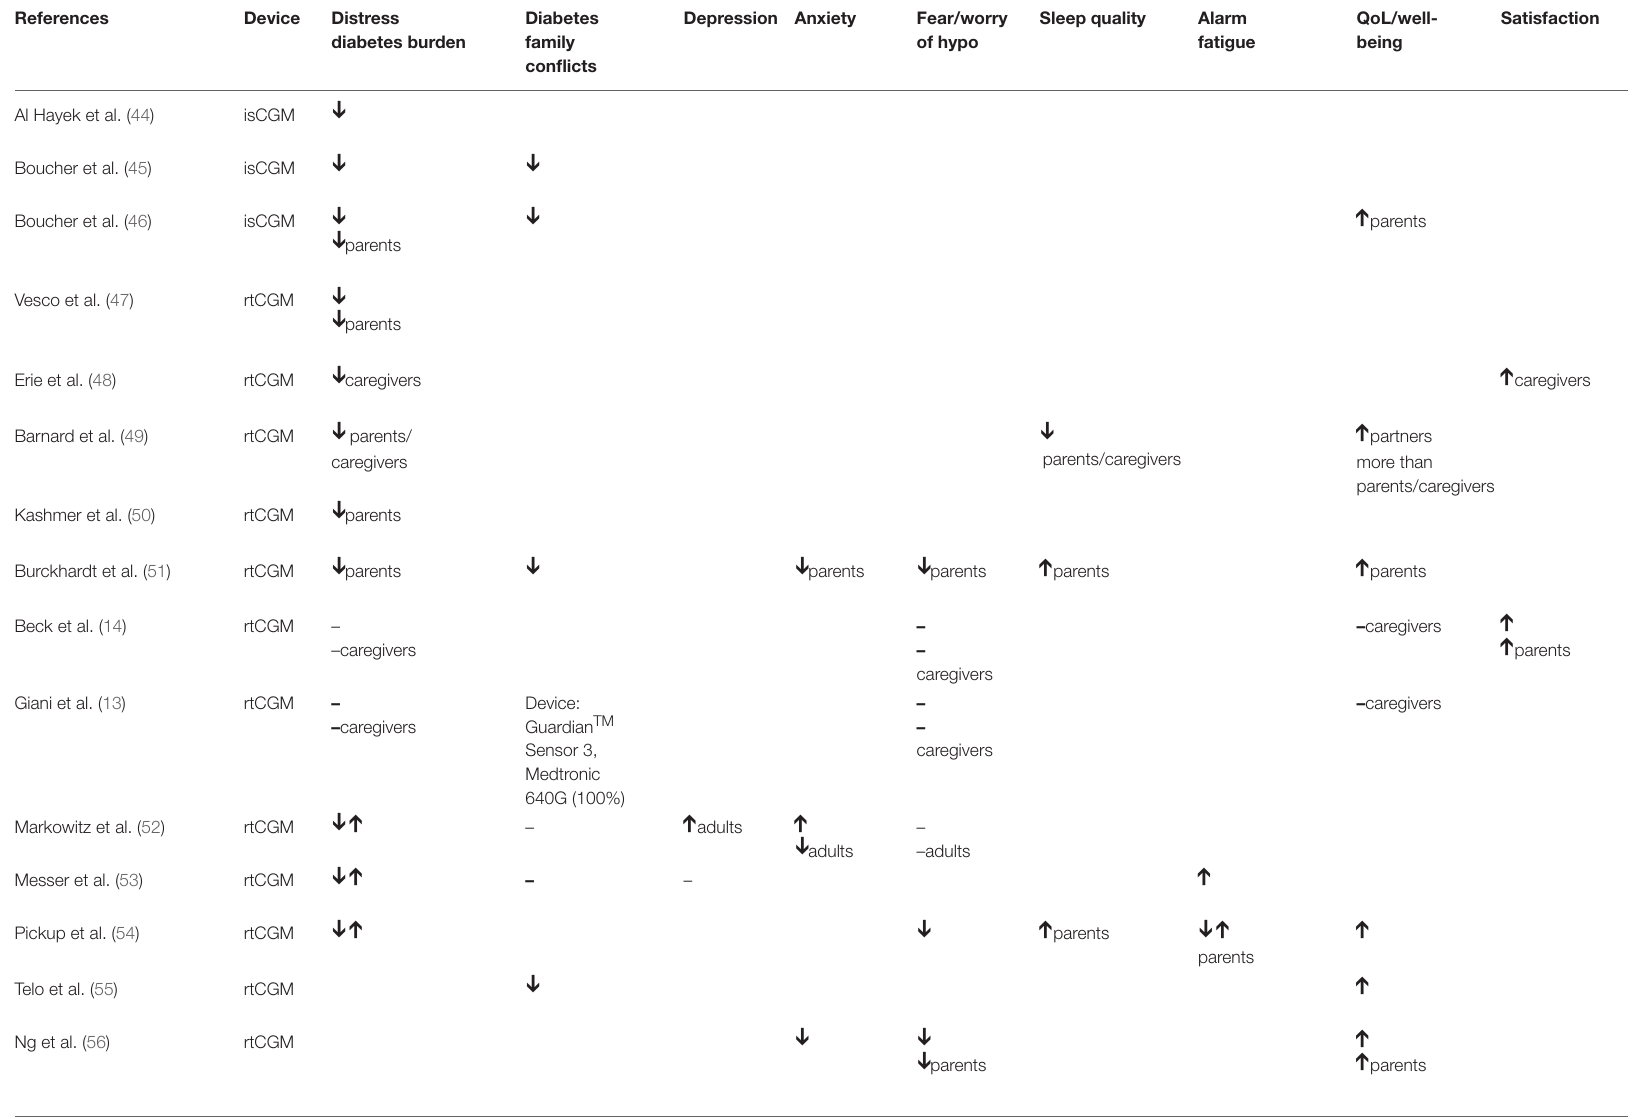
TABLE 3 | Summary of the evidence: rtCGM and isCGM impact on psychological outcomes in children (and parents/caregivers where